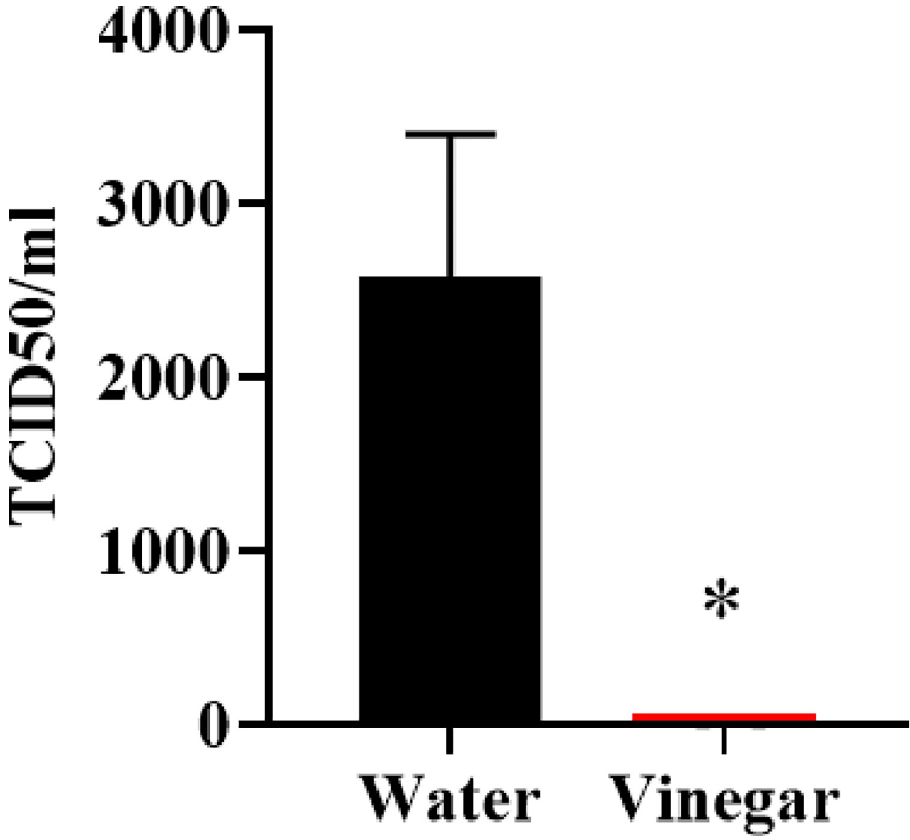
Fig 1. Vinegar (6% acetic acid) inactivates SARS-CoV-2. SARS-CoV-2 (1x10^5 TCID50, WA1/2020 isolate) was incubated with 6% acetic acid (or distilled water negative control) for 15min at a 1:10 ratio. The sample was then diluted 1:100 using water and tested for live virus by TCID50. TCID50 was read 10 days after experimental set up but left in culture for an additional week to ensure that no additional viral outgrowth occurred. Data represent mean ± SD, n = 2 � p <